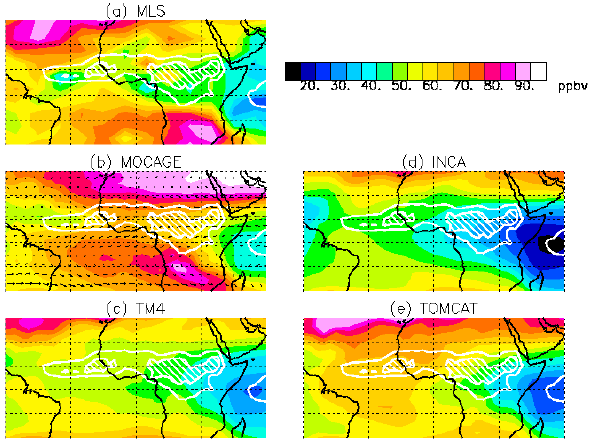
Fig. 9. August 2006 distributions of 250hPa O 3 difference between LiNO x -off and Conv-off simulations by (a) MOCAGE (b) TM4 (c) INCA and (d) p-TOMCAT. White contours represent the same dif- ferences but for tropospheric columns of O 3 with 1DU intervals from − 2 to